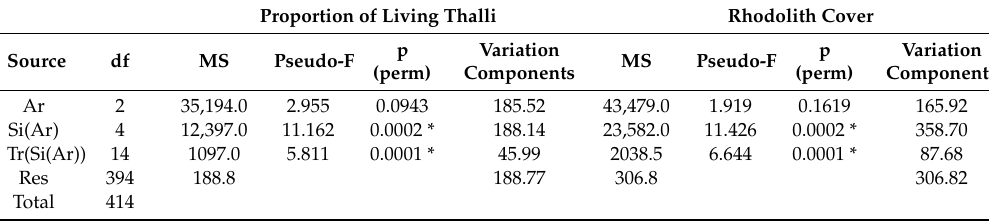
Table 2. Results of PERMANOVAs testing for spatial di ff erences in the proportion of living thalli and the rhodolith cover percentage at scales of area, site and transect. Estimates of multivariate variation are given for each spatial scale. df = degrees of freedom; MS = mean sum of squares; Pseudo-F = F value by permutation; p (perm) = p -values based on 9999 random permutations of appropriate units. Proportion of Living Thalli Rhodolith Cover p Variation p Variation Source df MS Pseudo-F MS Pseudo-F (perm) Components (perm) Components